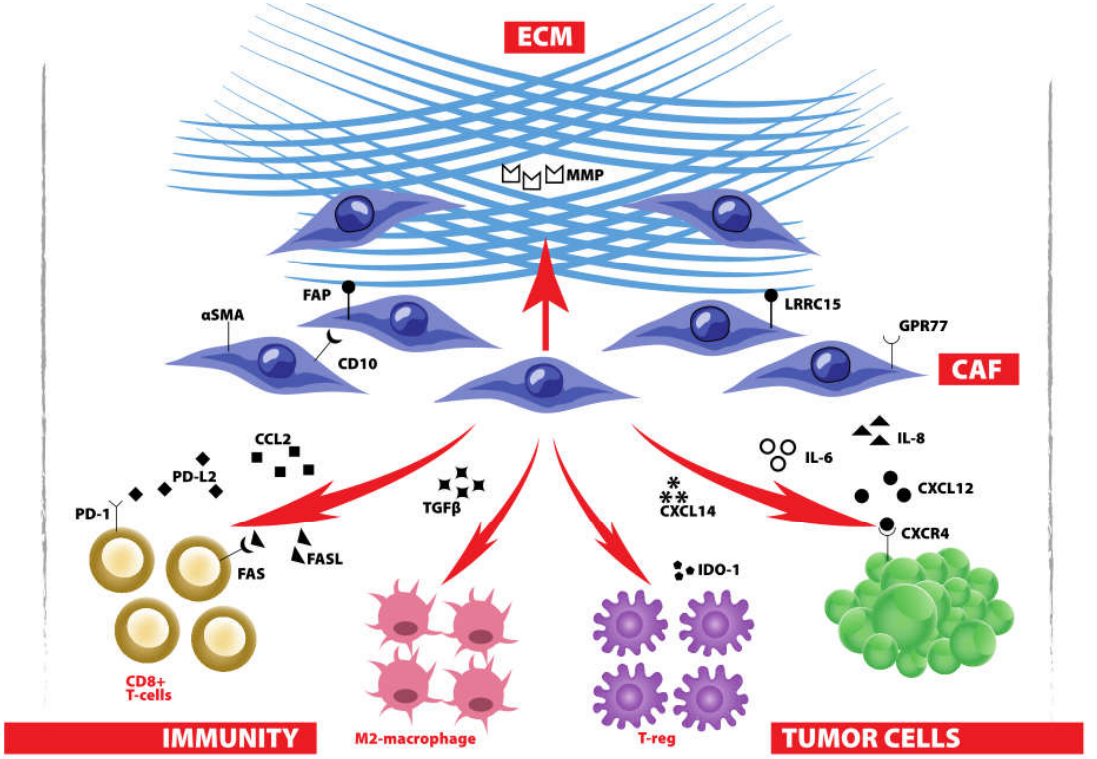
Figure 2. CAF and their essential role in the TME: CAF secrete cytokines to promote cancer growth and shape antitumor immunity; CAF control ECM composition to avoid drug penetration, favor tumor migration and mediate exclusion of antitumor immunity from the tumor.